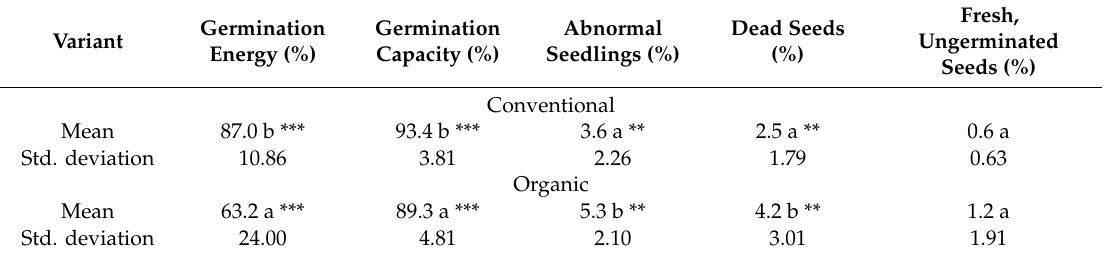
Table 4. Germination characteristic of 30 wheat cultivars grown in conventional and organic field. Fresh, Germination Germination Abnormal Dead Seeds Ungerminated Variant Energy (%) Capacity (%) Seedlings (%) (%) Seeds (%) Conventional Mean 87.0 b *** 93.4 b *** 3.6 a ** Std. deviation Mean Std. deviation